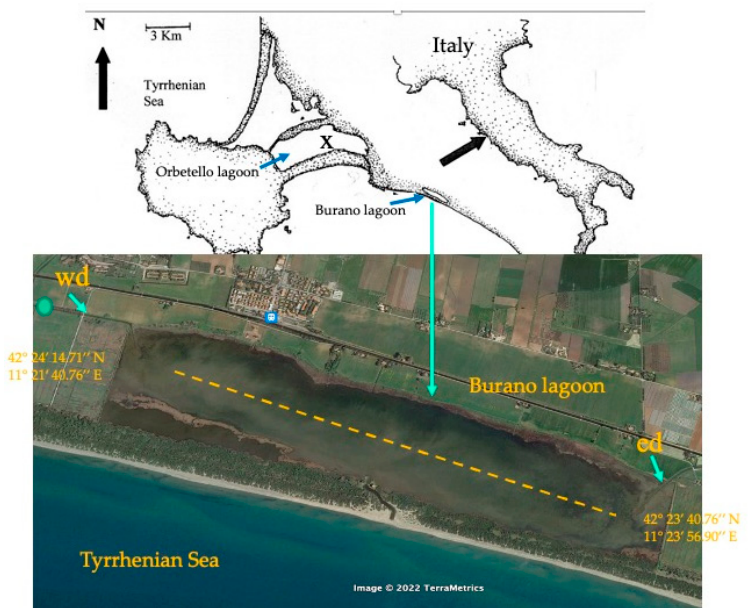
Figure 4. The Burano lagoon along the south Tuscany coast (Italy). In the center of the basin, in hatching, the transect for sampling and detection of the water physicochemical and nutrient variables, and sediment organic matter; wd, western ditch; ed, eastern ditch; dot, top left, sampling station for nutrient variables; x, in the eastern basin of the Orbetello lagoon, the meteorological control unit.